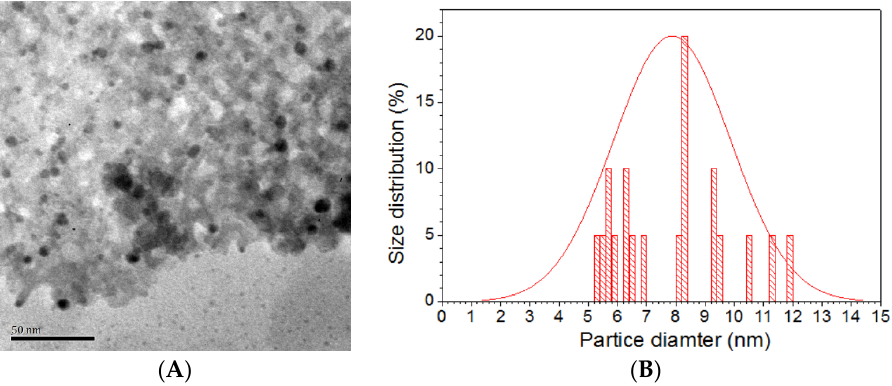
Figure 1. TEM image ( A ) and size distribution ( B ) for a 5 wt % Pd ‐ Cu (50:50) alloy particles supported